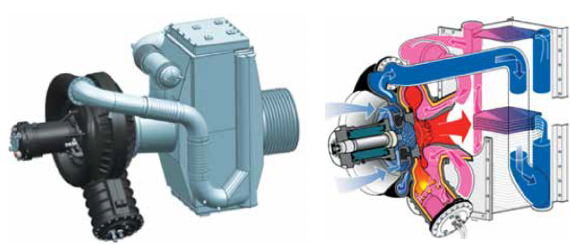
Figure 1. Powertrain representation of the T100.